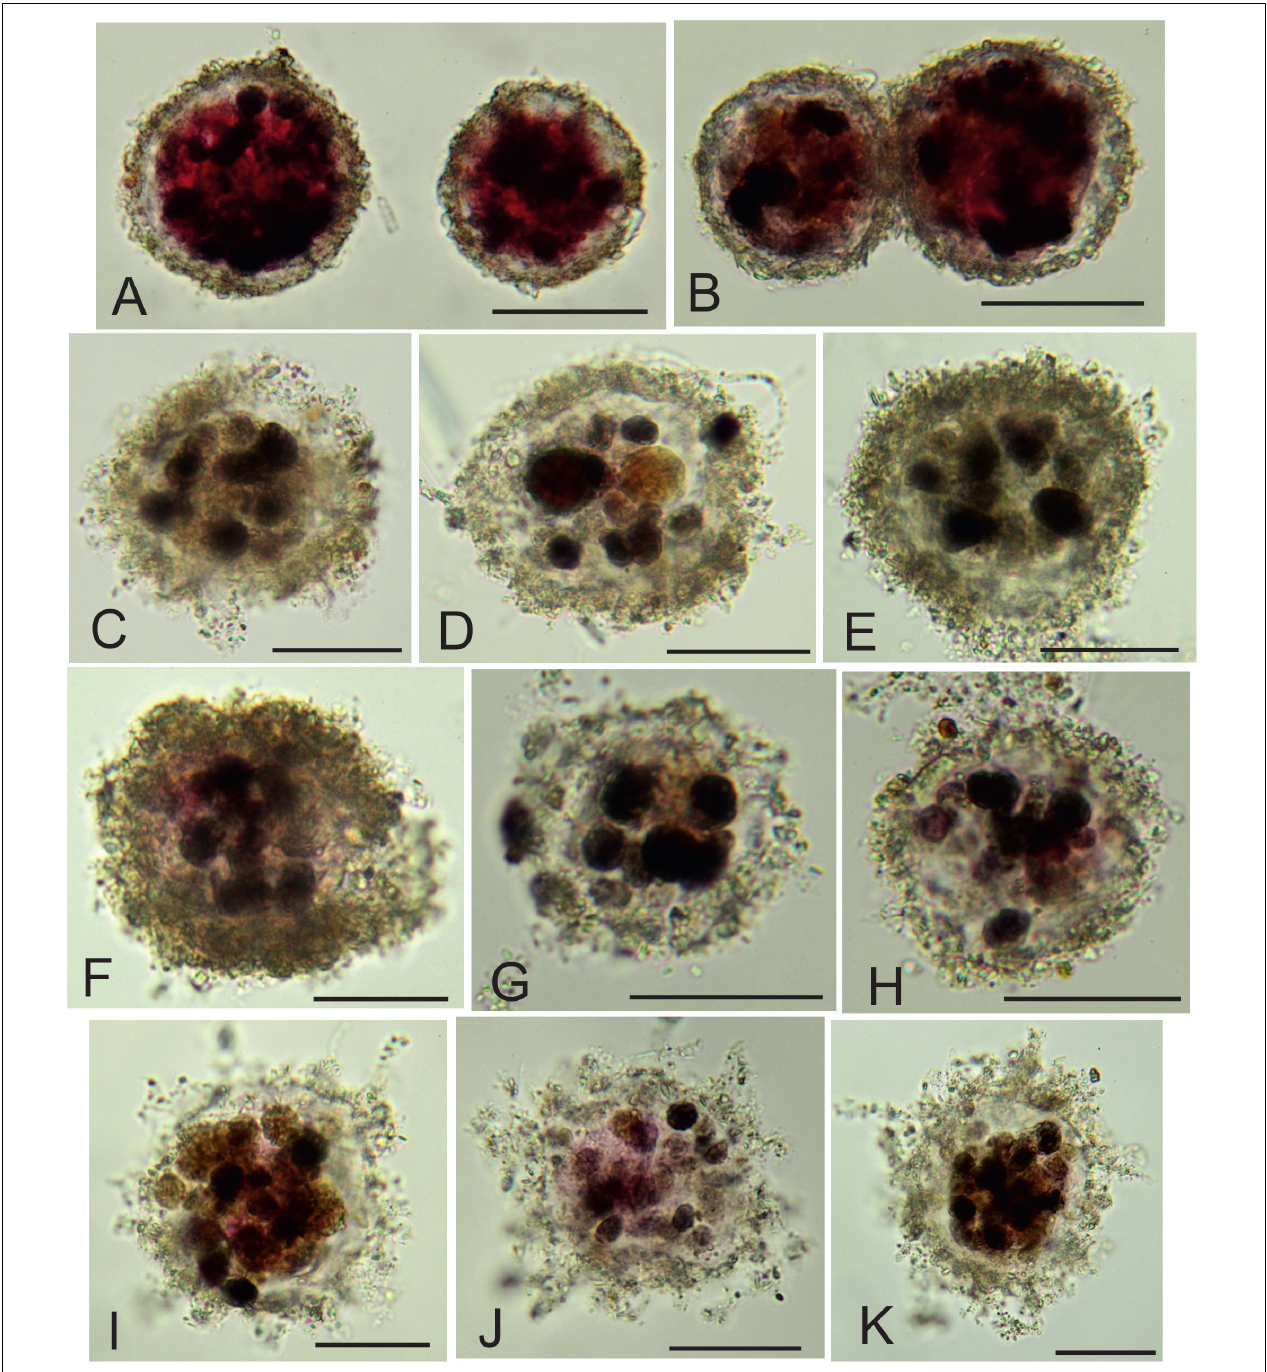
FIGURE 4 | Undescribed spherical foraminifera from 63 to 125 µ m fractions. (A,B) Psammosphaerid sp. 20, the most abundant morphospecies species in the stained assemblage; MC13, 0.5–1.0 cm. (C–H) Morphotype with delicate, fine-grained wall enclosing stercomata and sparse cytoplasm; all are from sample MC05. (I–K) Similar morphotype in which the wall includes an organic layer with finely agglutinated particles and gives rise to short filament-like structures; all are from sample MC05. Scale bars = 50 µ m.